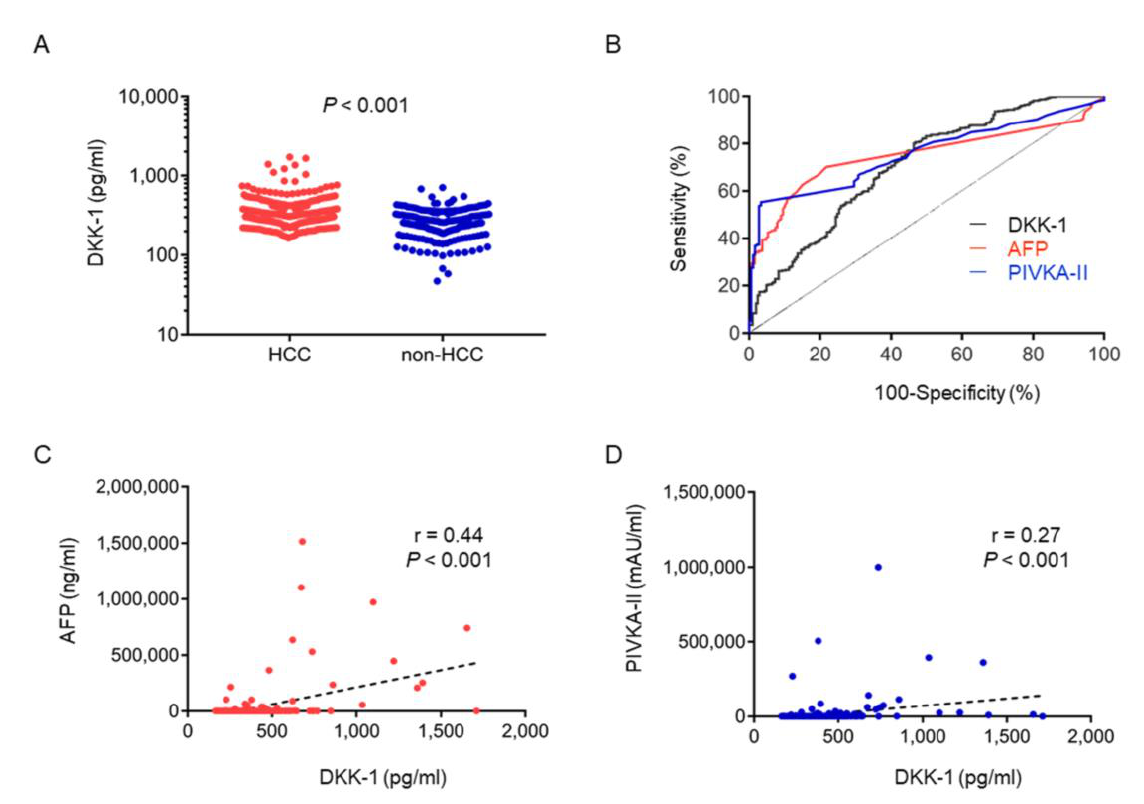
Figure 2. Serum Dickkopf-1 (DKK-1) levels as a diagnostic marker for hepatocellular carcinoma (HCC). ( A ) Serum DKK-1 levels were significantly higher in patients with HCC than in those without HCC. ( B ) A receiver operating characteristic (ROC) curve of serum DKK-1, alpha-fetoprotein (AFP), and protein induced by vitamin K absence-II (PIVKA-II) levels. The optimal cutoff value of serum DKK-1 levels for the diagnosis of HCC was 262.2 pg/mL. The area under the ROC curve of serum DKK-1 levels was 0.708. The sensitivity and specificity of DKK-1 were 80.5% and 53.2%, respectively. ( C , D ) The correlation (r) between serum DKK-1 and serum AFP levels was 0.44 ( p < 0.001; C ), whereas that between serum DKK-1 and serum PIVKA-II levels was 0.27 ( p < 0.001; D ).